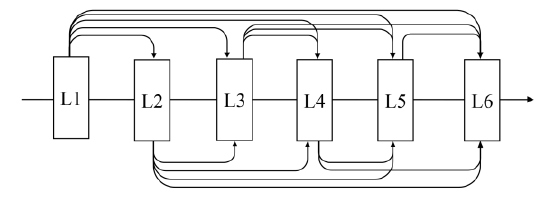
Figure 2. The structure of a dense block